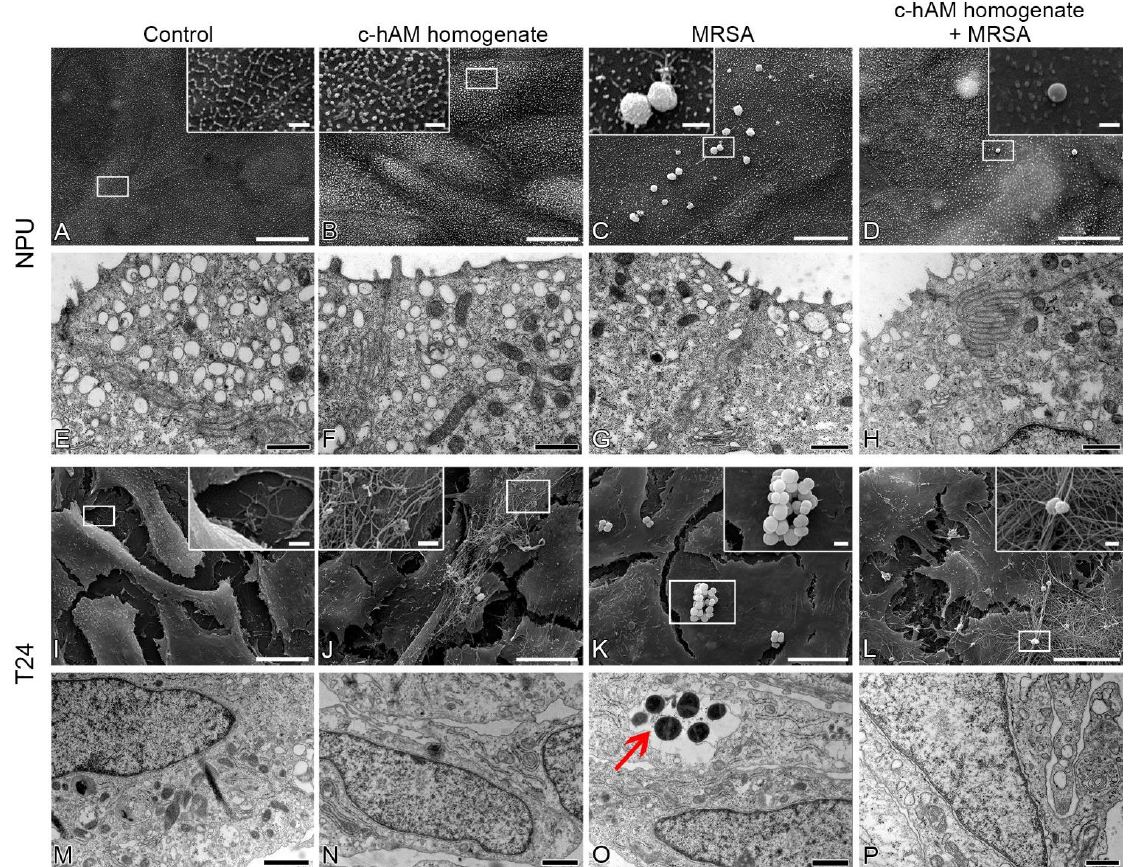
Figure 7. The effect of short-term incubation in the c-hAM homogenate and/or MRSA on the ultrastructure of biomimetic in vitro models of the normal and cancerous urothelium. ( A , B , E , F ) Short-term (3 h) treatment of the NPU cells with the c-hAM homogenate does not affect the ultrastructure of NPU cells. ( C , D , G,H ) During the 3 h incubation in the culture medium inoculated with MRSA, individual bacteria or small aggregates of MRSA attached to the surface of NPU cells. During the 3 h incubation in the c-hAM homogenate inoculated with MRSA, a smaller number of individual bacteria attached to the surface of NPU cells. ( I , J , M , N ) A short-term treatment of the T24 cells with the c-hAM homogenate does not affect the ultrastructure of T24 cells. ( K , O ) During the 3 h incubation in the culture medium inoculated with MRSA, aggregates of MRSA attached to the surface of the T24 cells and some of them were endocytosed by the T24 cells. ( L , P ) During the 3 h incubation in the c-hAM homogenate inoculated with MRSA, a smaller number of individual bacteria or small aggregates of bacteria attached to the surface of T24 cells. Large insets framed with white lines ( A – D , I – L ) show the enlarged areas of the corresponding small white-framed insets. Data were obtained from three independent replications of experiments using three biological samples of hAM. Arrow: An aggregate of MRSA in the endosomal compartment. Scale bars: ( A – D , I – L ) 10 µm; (enlarged areas in A – D , I – L ) 1 µm; ( E – H , M – P ) 600 nm.